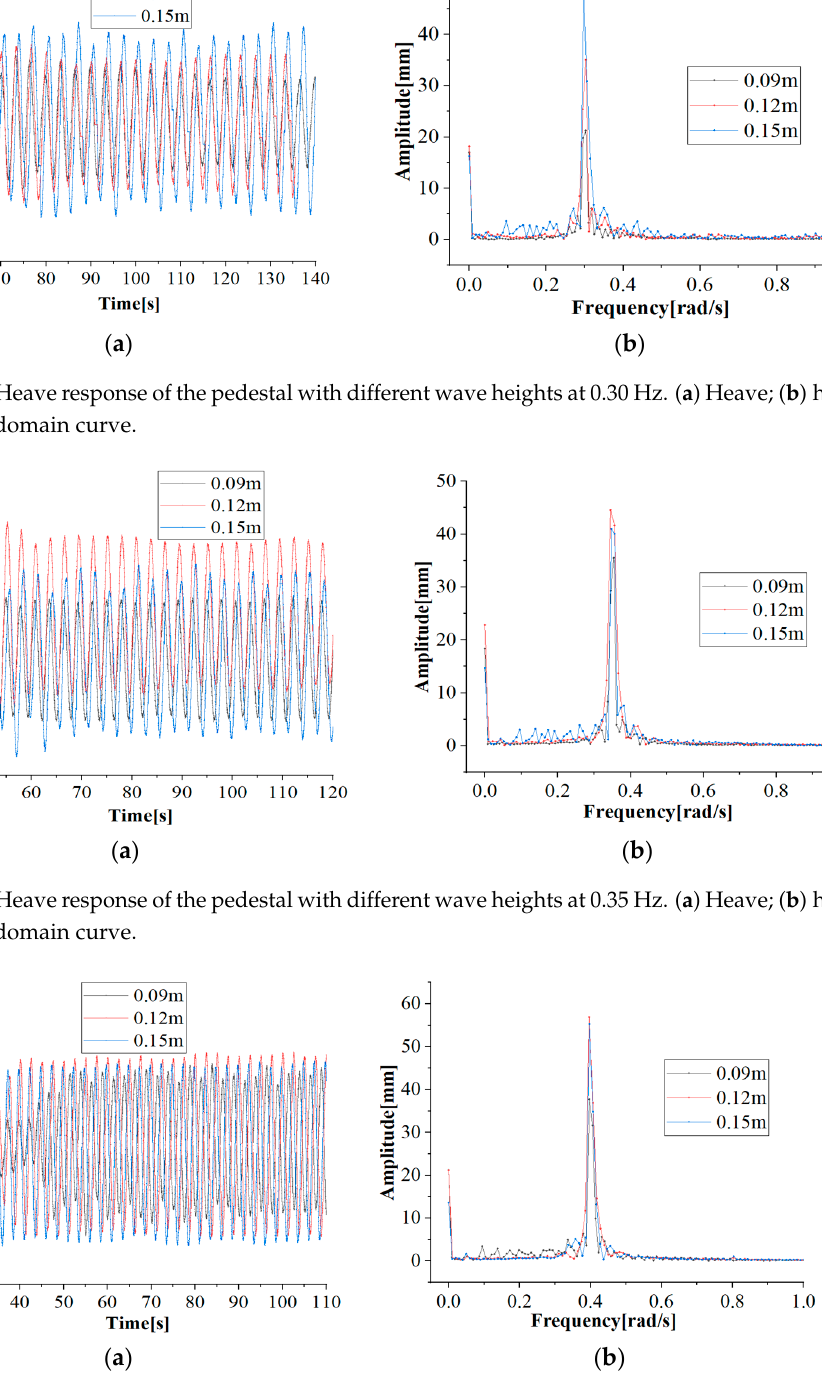
Figure 24. Standard deviation of heave response at different frequencies. 3. Numerical Simulations 3.1. Model Parameters and Working Conditions In this chapter, the numerical simulation part of this study is introduced. The numerical simulation model refers to the platform in the above. In the research process, the wave period ( T ) and wave height ( H ) of numerical simulation are preset according to the working conditions that can be met by physical experiments. The types of wave periods and wave heights are listed in Table 3. There are five wave periods and five wave heights combined, for a total of 25 working conditions. Table 3. Working conditions of waves. Wave Periods [s]